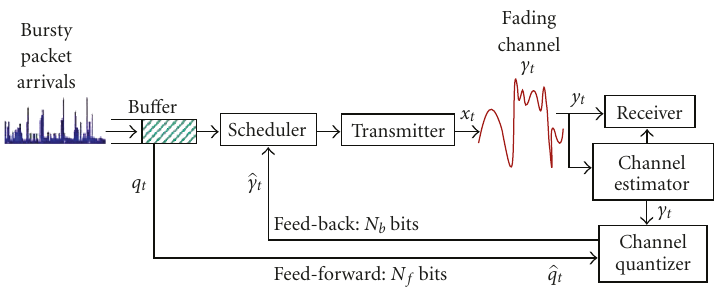
Figure 1: Schematic of proposed system incorporating both feedback and feed-forward